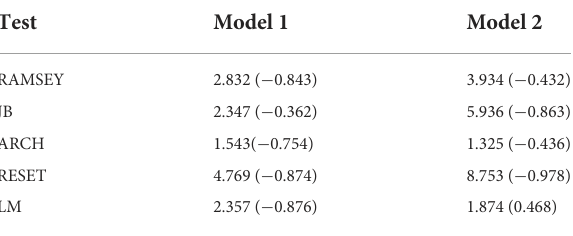
TABLE 7 Findings of the diagnostic